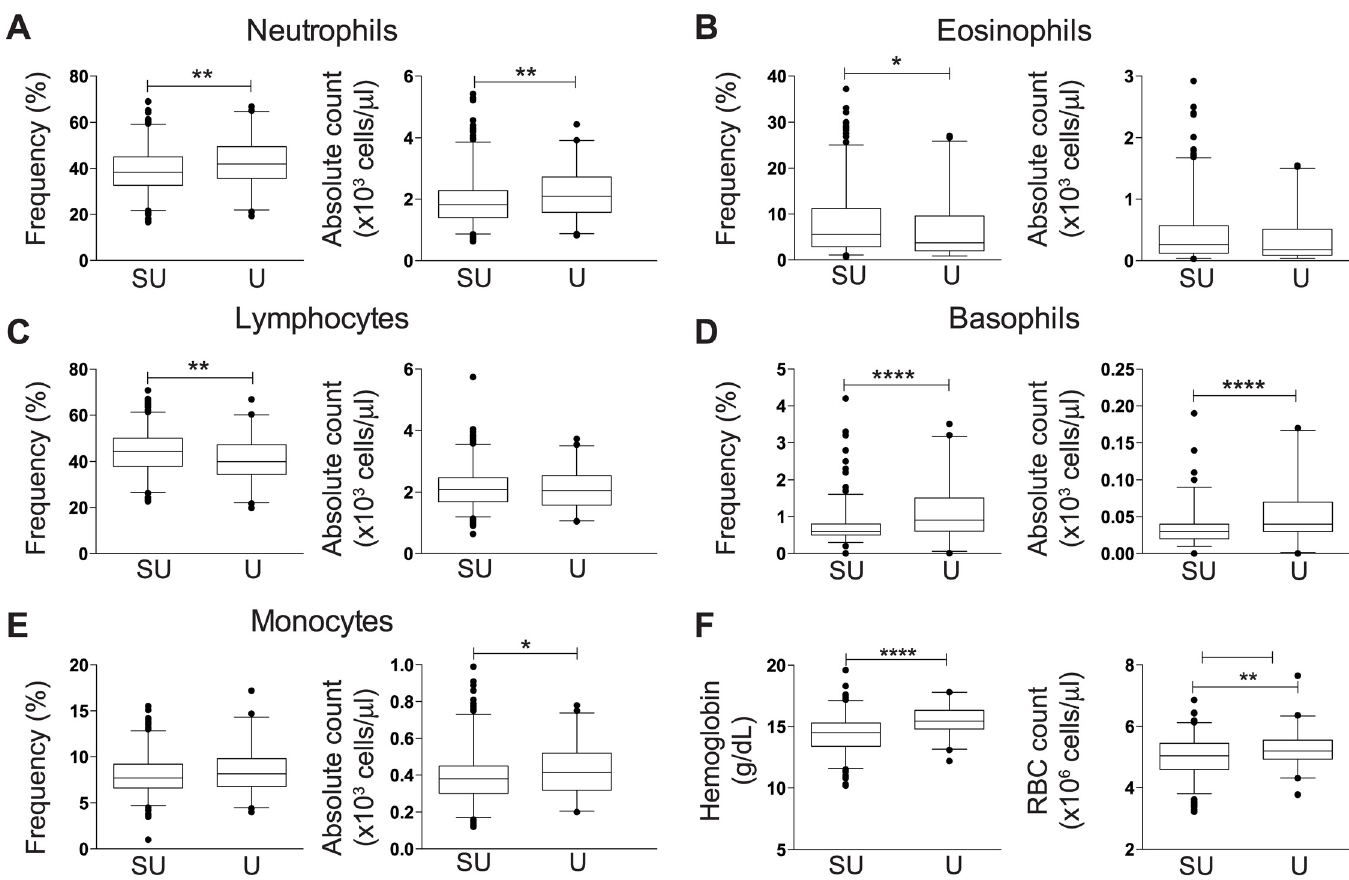
Fig 1. Comparison of hematological parameter frequency and absolute counts in males. Box and whisker plots showing median and 2.5 – 97.5 percentiles of (A) neutrophils in semi-urban blood bank donors [SU] and vaccine trial [U]; (B) eosinophils; (C) lymphocytes; (D) basophils; (E) B monocytes; and (F) hemoglobin levels and RBC counts. The non-parametric Mann Whitney U test was used to determine any statistically significant differences between cohorts; * p < 0.05, ** p < 0.01, *** p < 0.001, **** p <